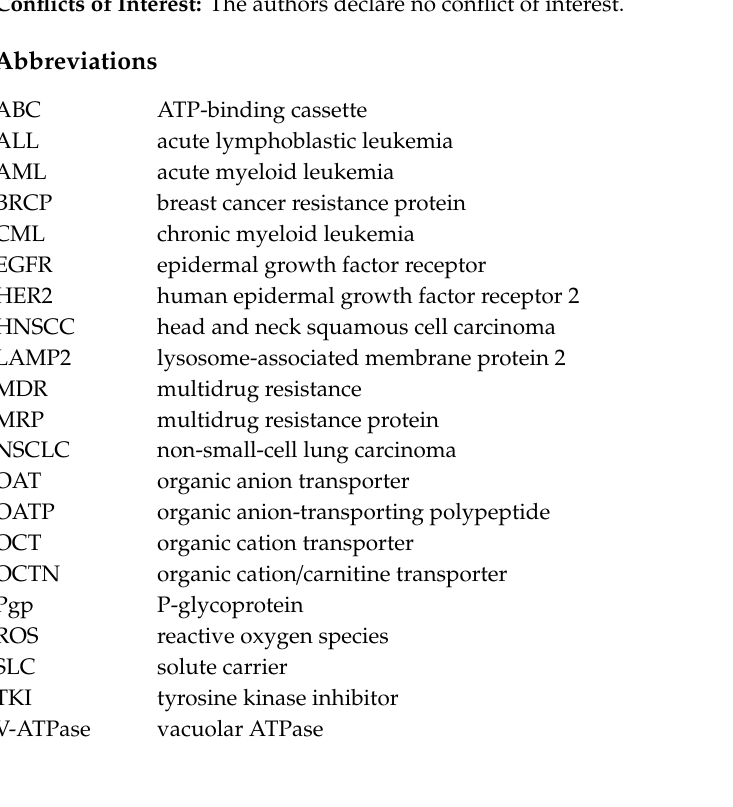
Table S1: FDA-approved TKIs and their molecular targets, Table S2: An example of TKIs under investigation and their molecular